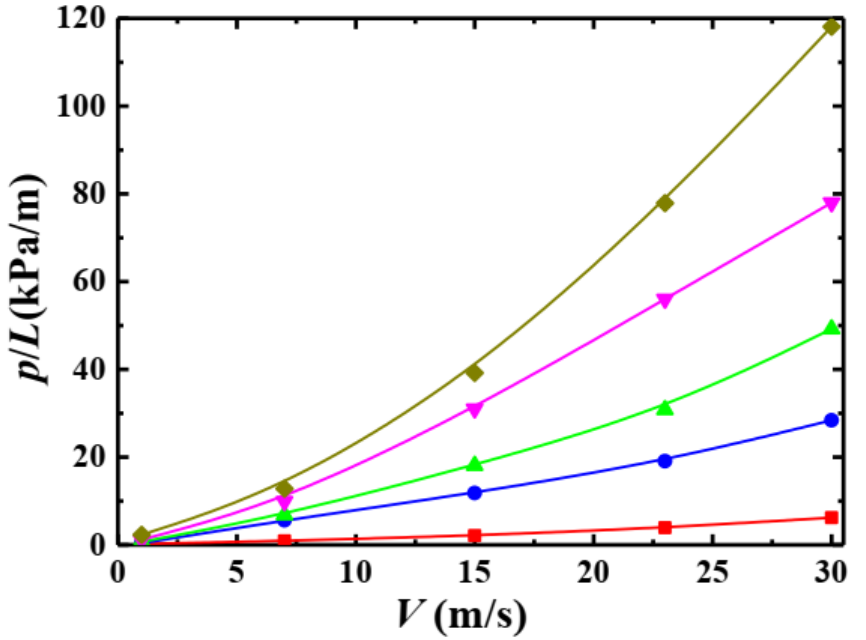
Figure 10. Relationship between p / L and V for different concentrations ( d p = 100 µ m, m s = 15 t/h).